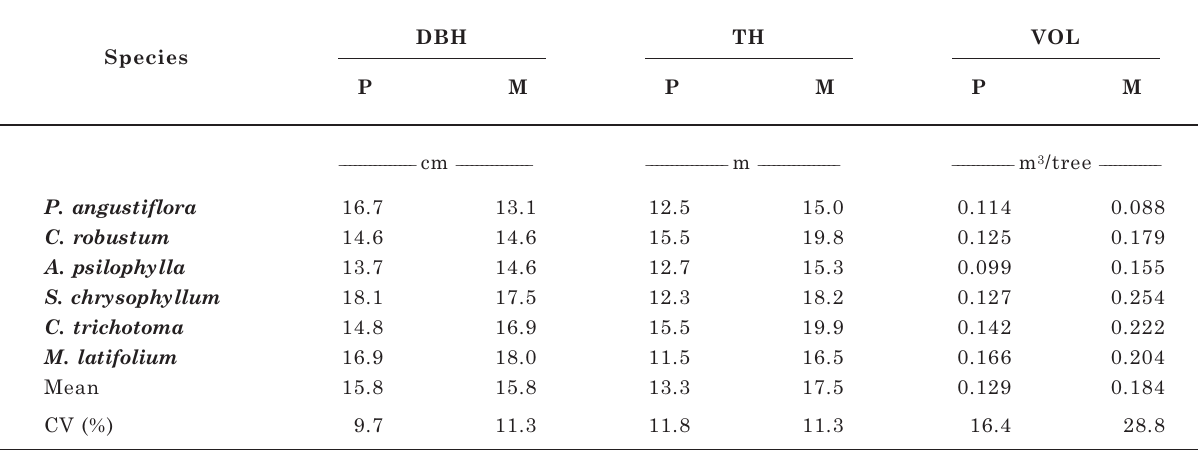
Table 1. Diameter at breast height (DBH), total height (TH) and tree stem volume (VOL) of native forest species, in pure (P) and mixed stands (M)